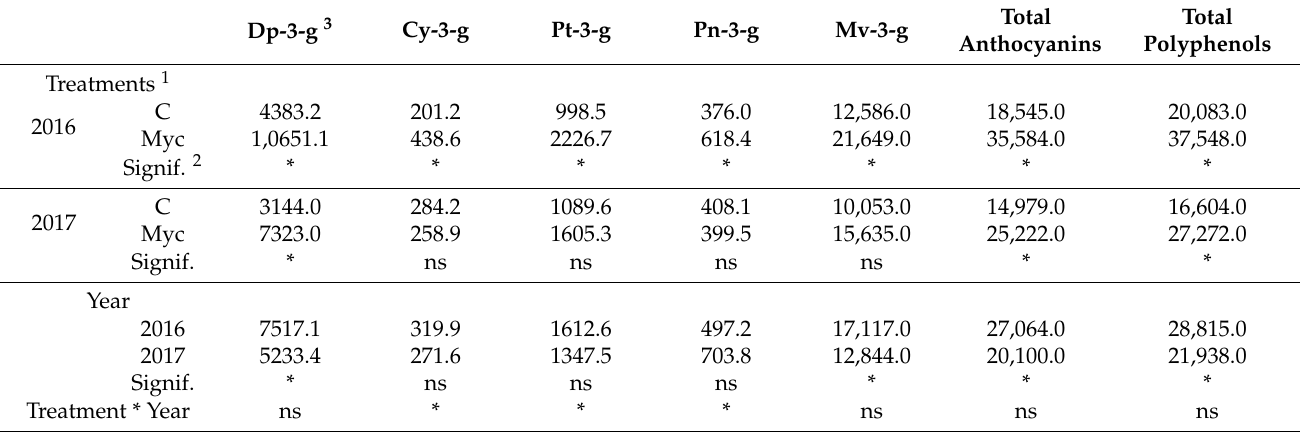
Table 7. Berry skin anthocyanins and total polyphenols (mg kg − 1 of the dry weight of grape skin) in mycorrhized and control